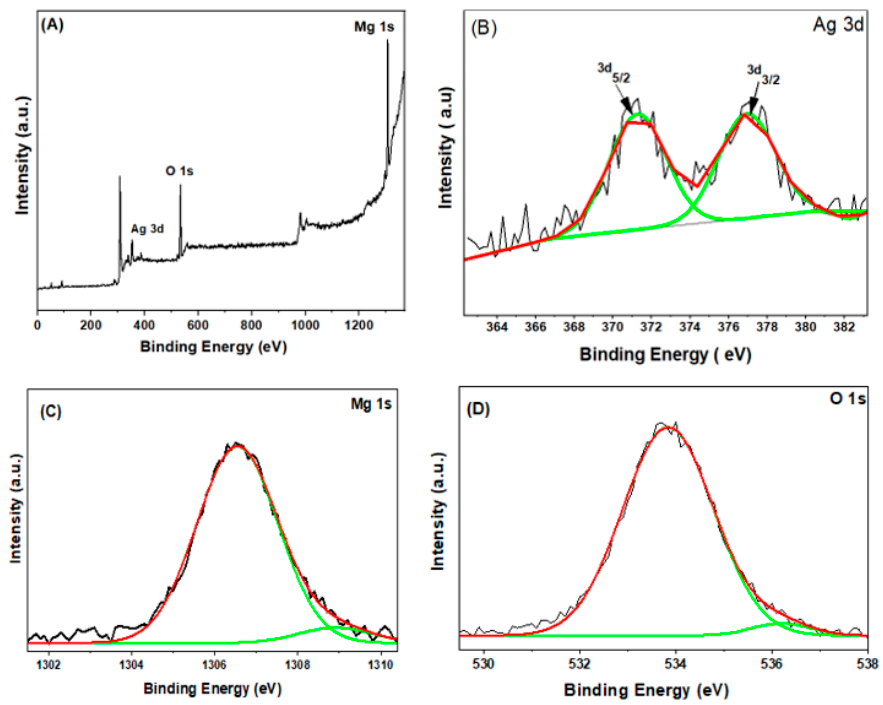
Figure 6. XPS survey spectra for 7.5 % Ag-doped MgO NPs ( A ), Ag 3d ( B ), Mg 1s ( C ), and O1s ( D ).